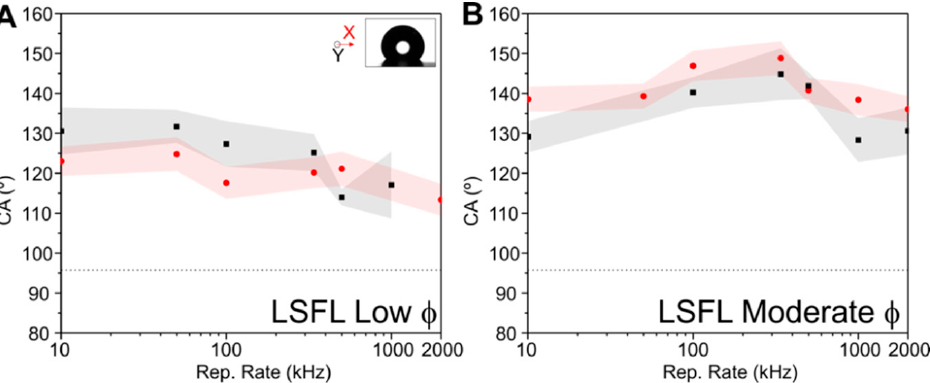
Figure 7. Contact angles (CA) measured from two different viewing positions X (red dots) and Y (black squares) of laser irradiated areas (droplet image included in the inset) for LSFL at ( A ) low and ( B ) moderate fluences. The horizontal dotted line corresponds to the CA measured on the un-irradiated sample surface for comparison. The error bars displayed as shadowed areas were determined as indicated in the Materials and Methods section.